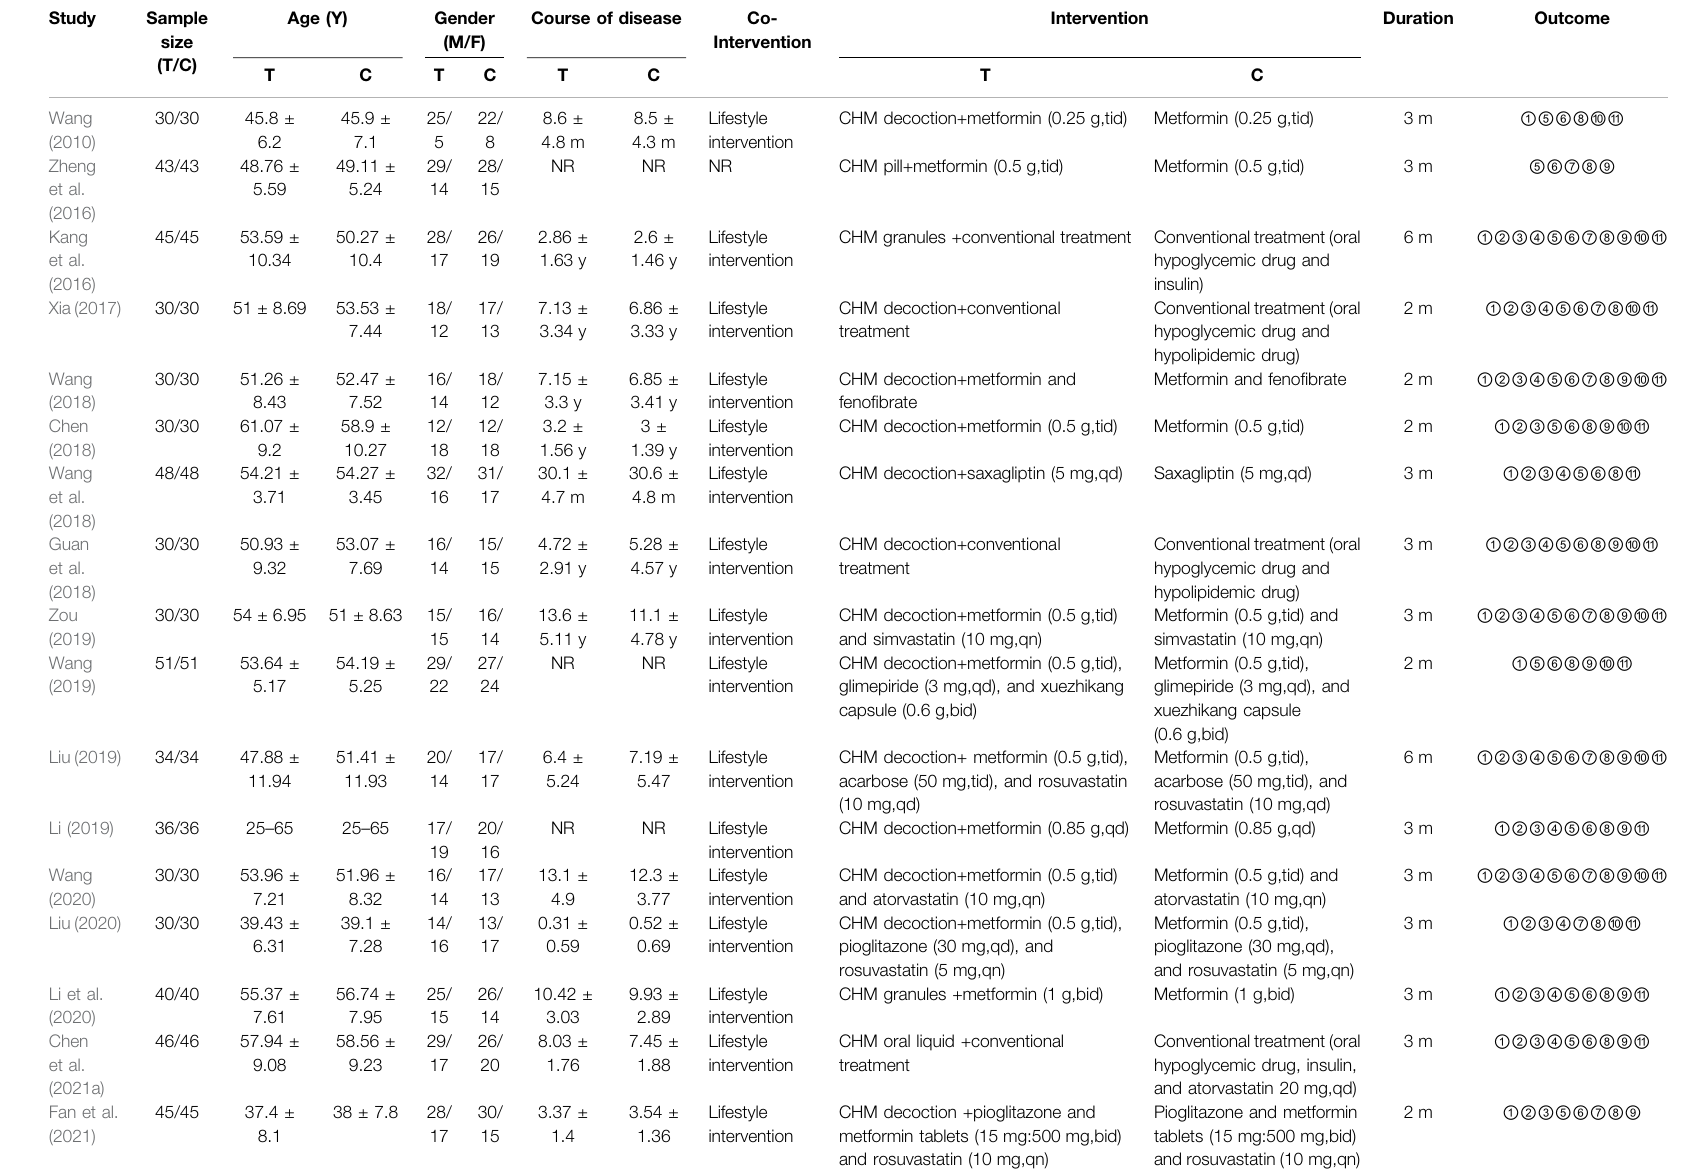
TABLE 1 | Characteristics of the included studies.